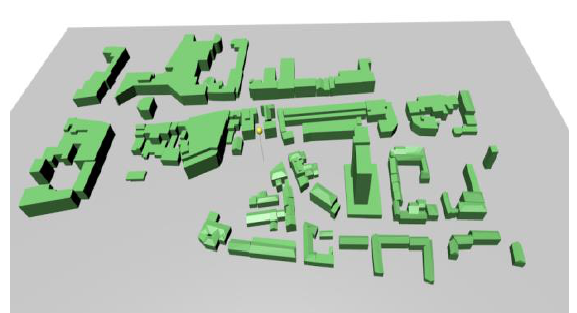
Figure 12. The sample CityGML dataset